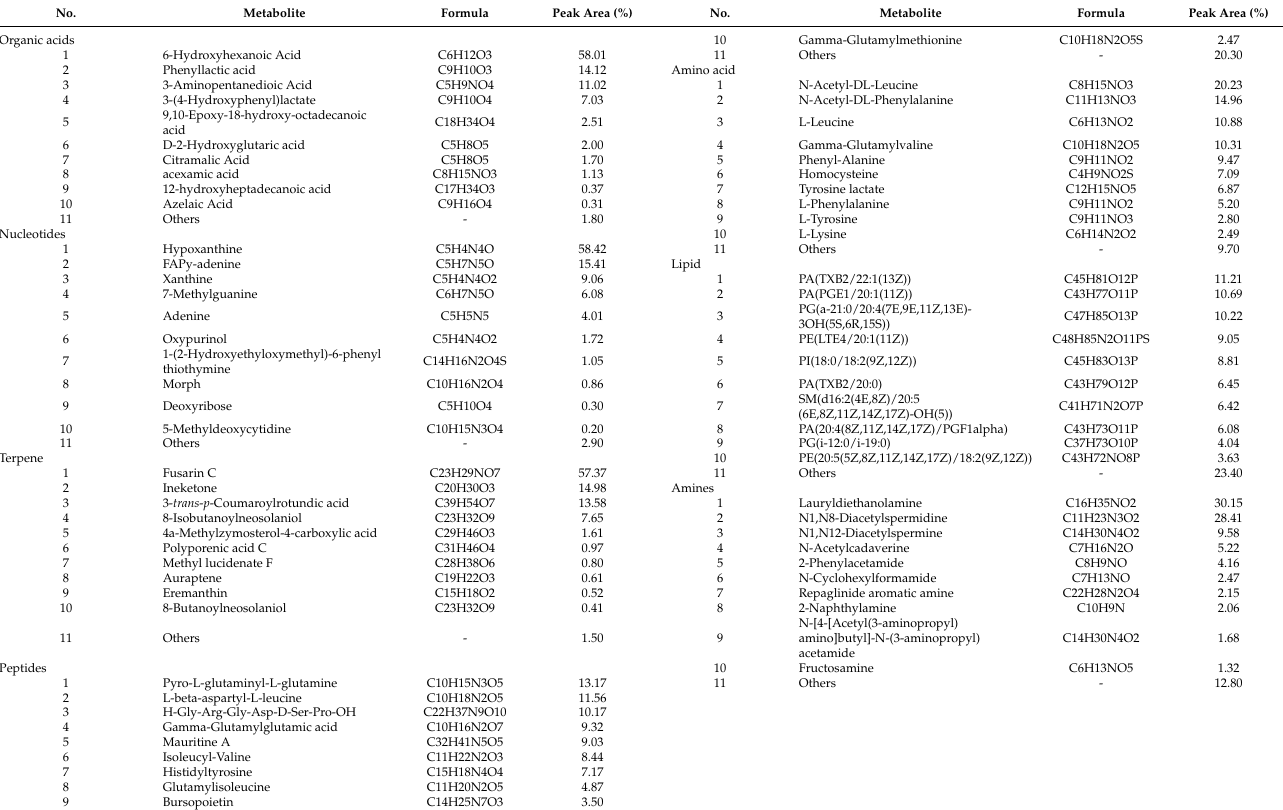
Table 2. Major compositions in ET-22-S by non-targeted metabonomics 1